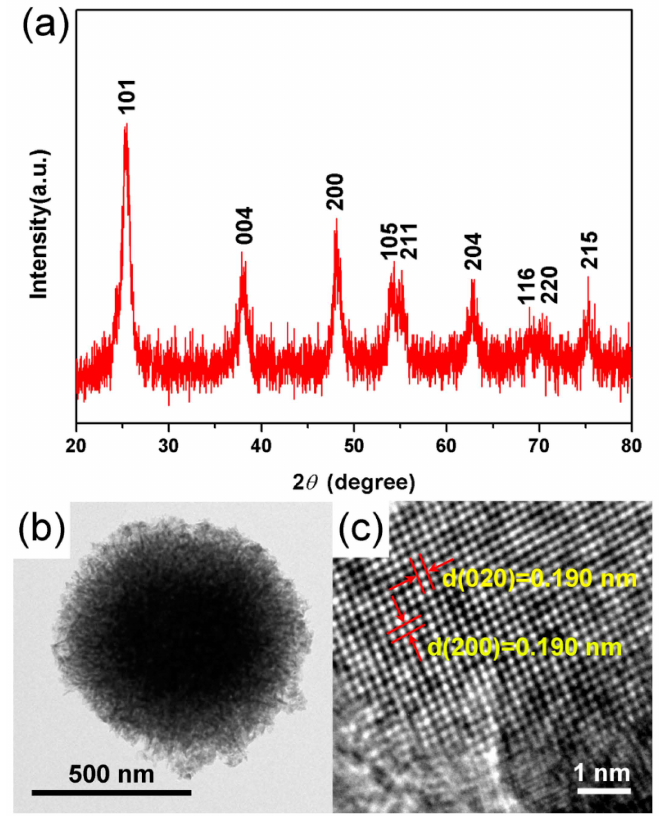
Figure 4. ( a ) XRD, ( b ) TEM, and ( c ) HRTEM images of the TiO 2 hierarchical nanospheres prepared for 24